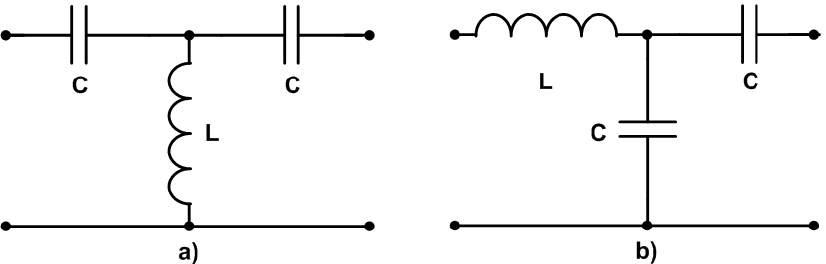
Figure 2. Feasible multi-resonant circuits for CPT system applications: ( a ) X-Tank; ( b ) Z-Tank.